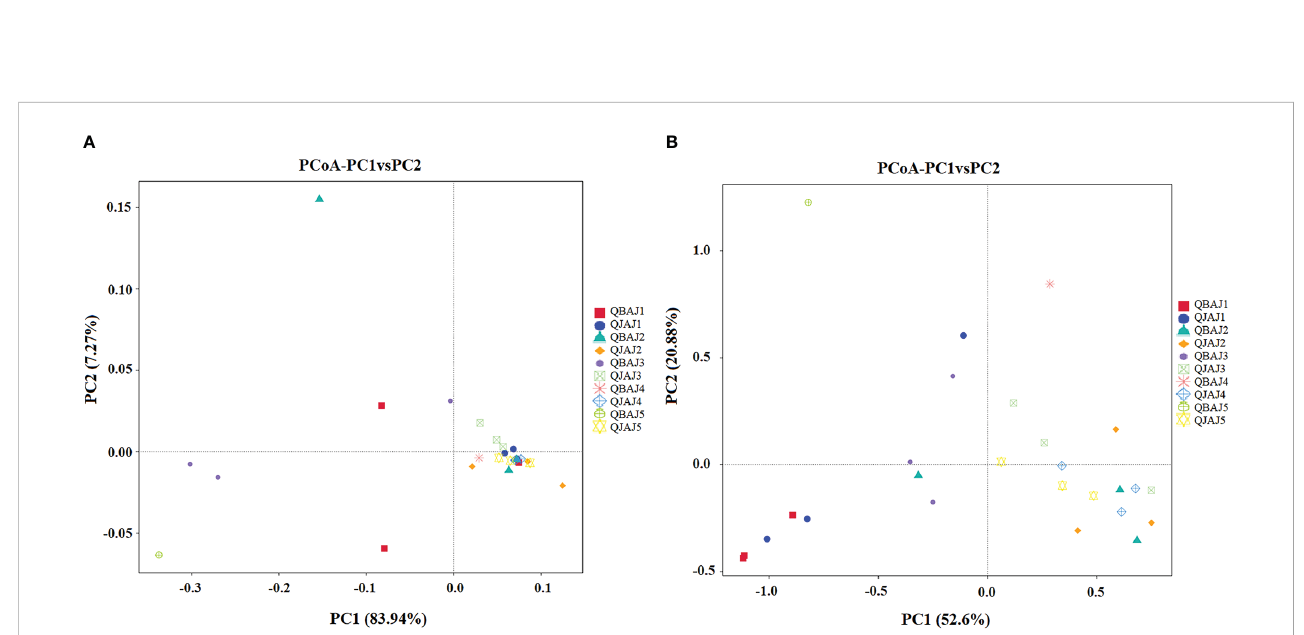
FIGURE 7 Principal Co-ordinate Analysis (PCoA) analysis of the bacterial (A) and fungal (B) communities in the different group